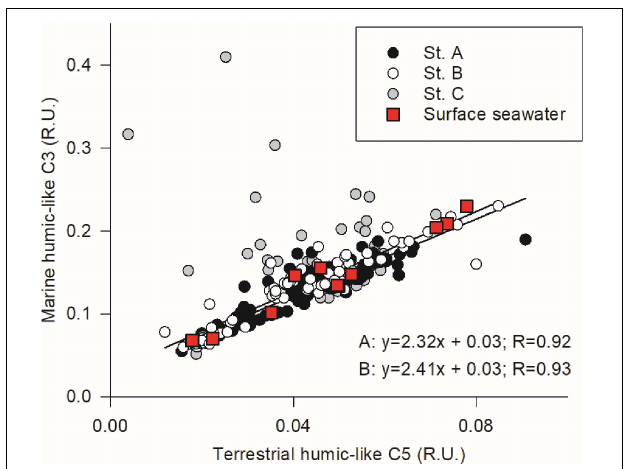
FIGURE 4 | Relationships of the two humic-like FDOM components identified through PARAFAC modeling of our dataset in the samples collected from the seepage meters and those collected from the surface seawater during low tide. Samples from the seepage meters are organized by sampling station.